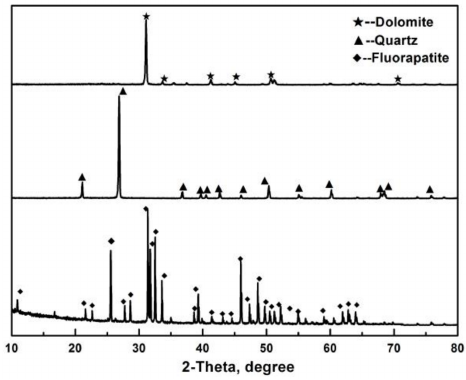
Figure 1. The XRD patterns of apatite, dolomite, and